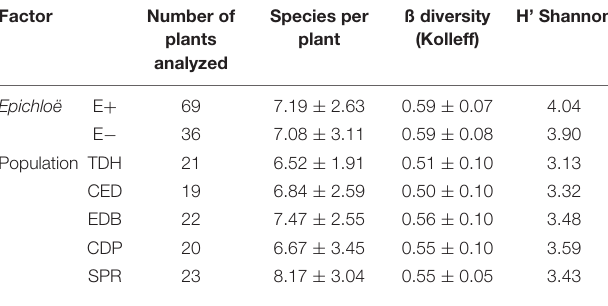
TABLE 3 | Fungal species richness and diversity in roots of Festuca rubra subsp. pruinosa plants infected (E + ) or not infected (E − ) by Epichloë festucae at five populations in marine